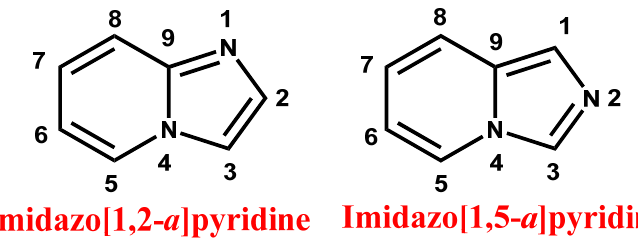
Figure 1. General structure and nomenclature of imidazopyridine.